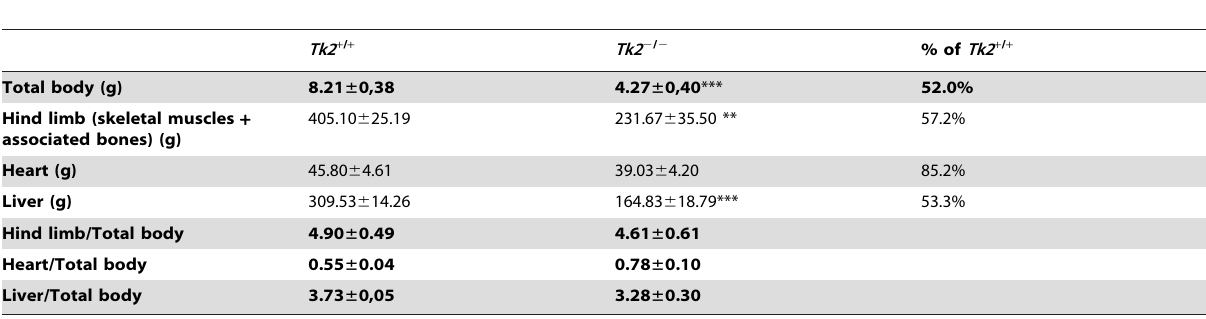
Table 1. Body and organs weights in 14 days-old Tk2 + / + and Tk2 2 / 2